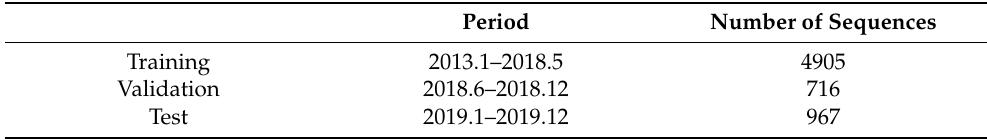
Table 1. Organization of training, validation, and test sets.